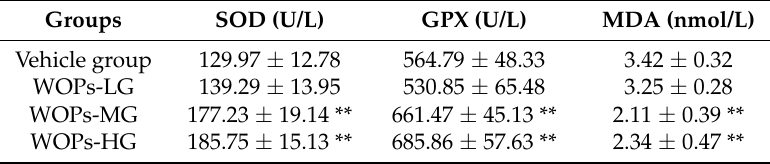
Table 3. Effects of WOPs on SOD, GSH-PX activity, and MDA contents in skeletal muscles of mice. Groups